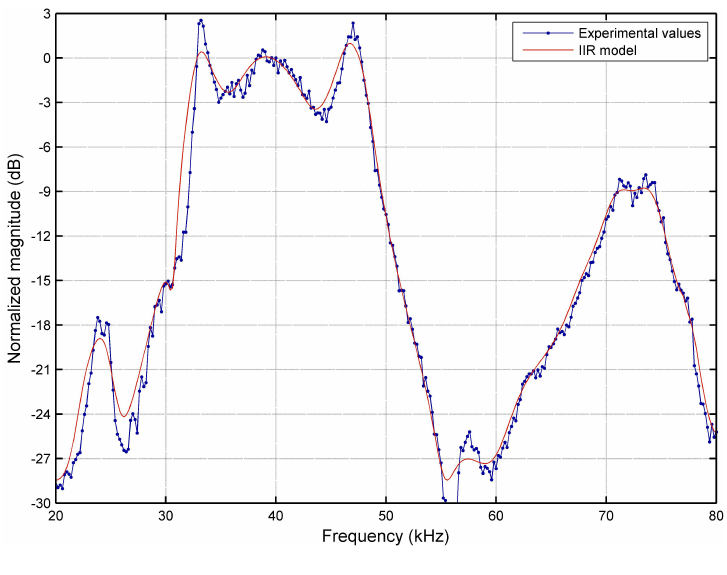
Figure 4. Emitter frequency response: experimental values (blue dotted) and IIR filter model (red solid).